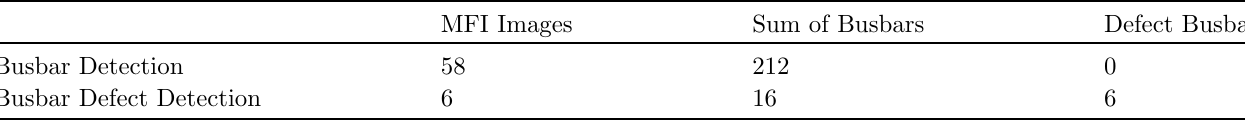
Table 4. Test data sets and the corresponding number of